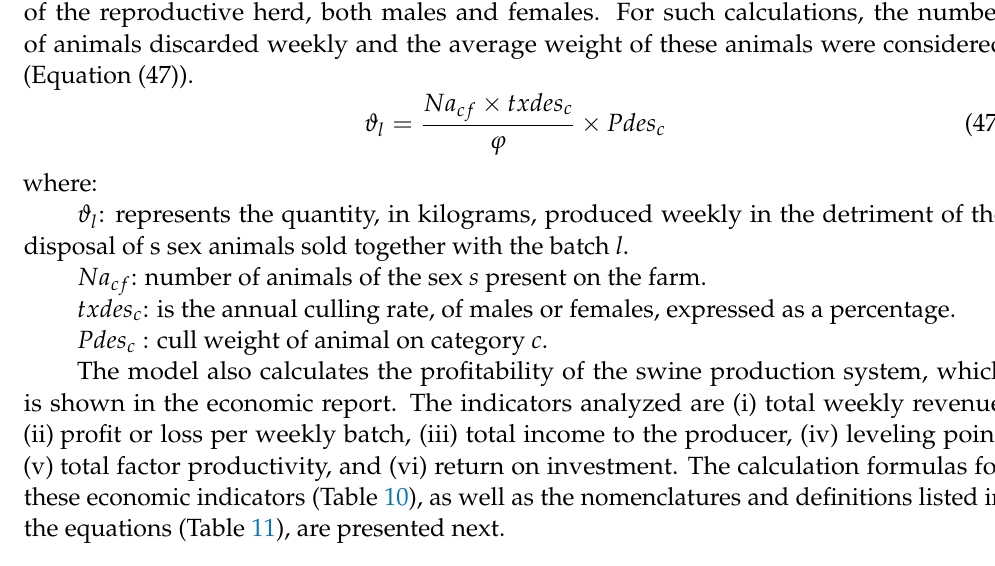
Table 10. Equations that make up the economic indicators that compose the cost calculation model for swine